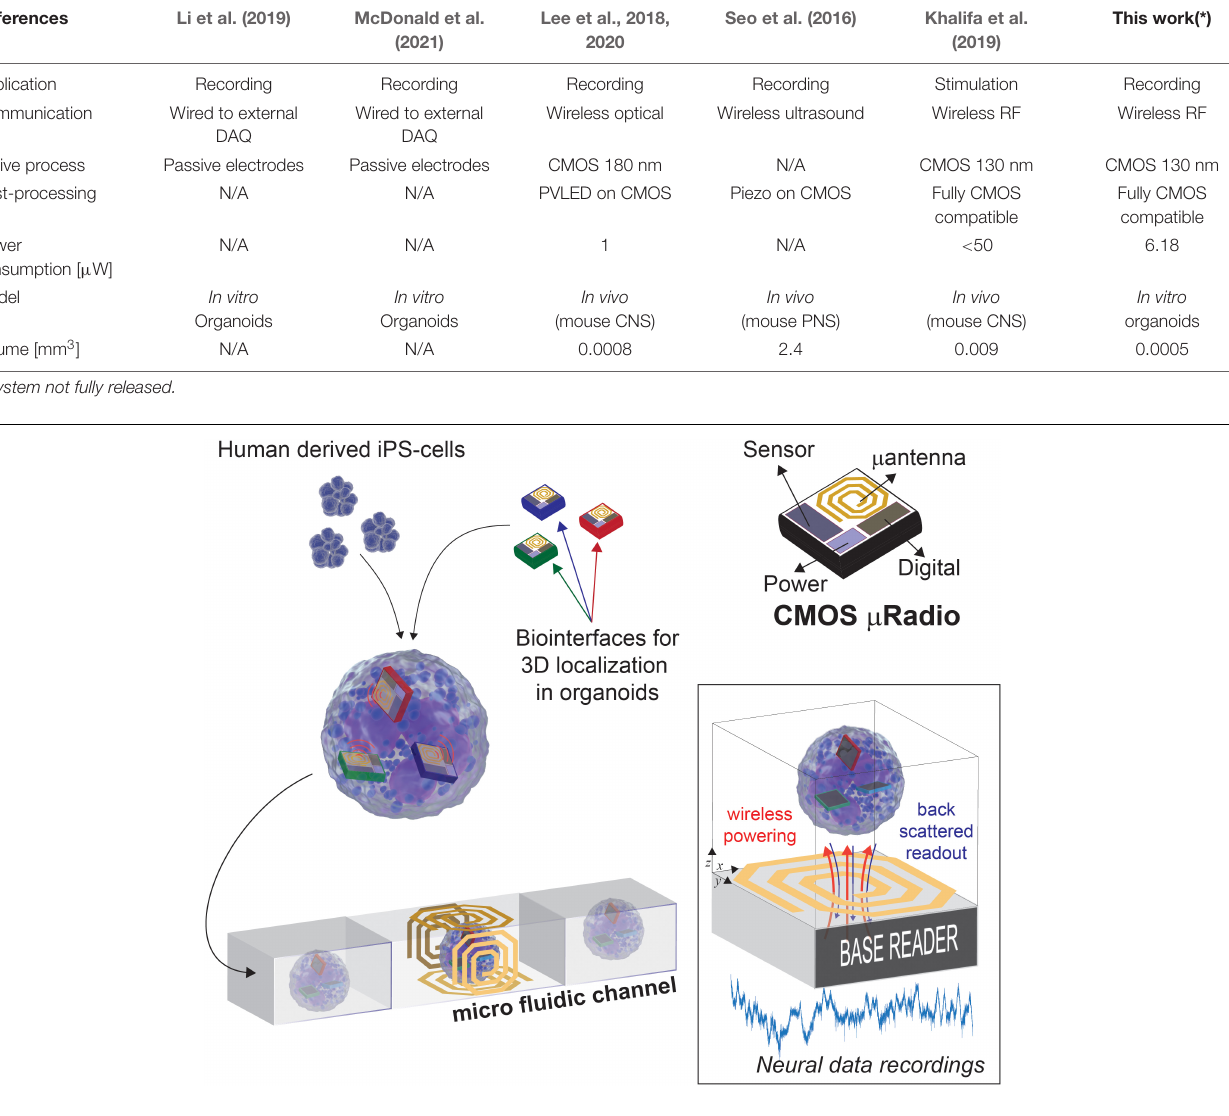
compact and reliable prototypes (Khalifa et al., 2019).